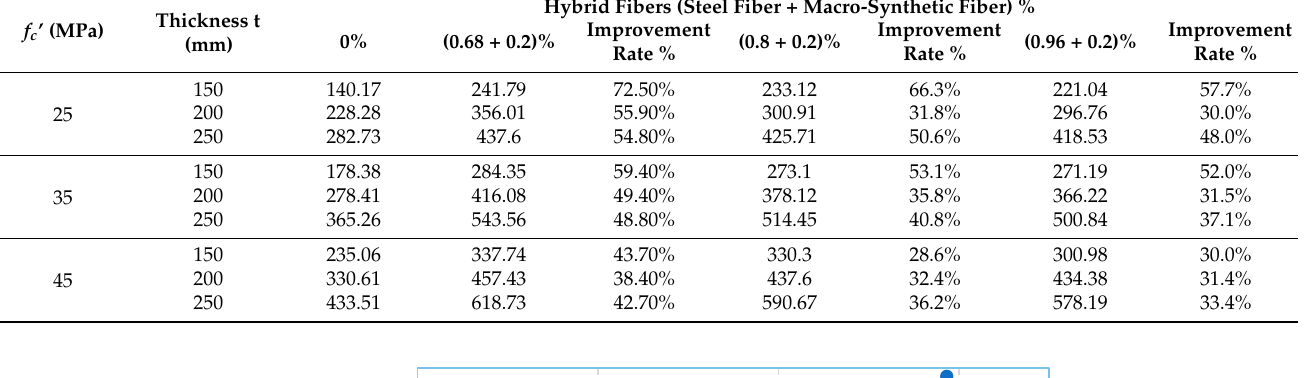
Table 4. Ultimate axle load capacity at the edge of mid slab Pu (kN) and improvement rate.